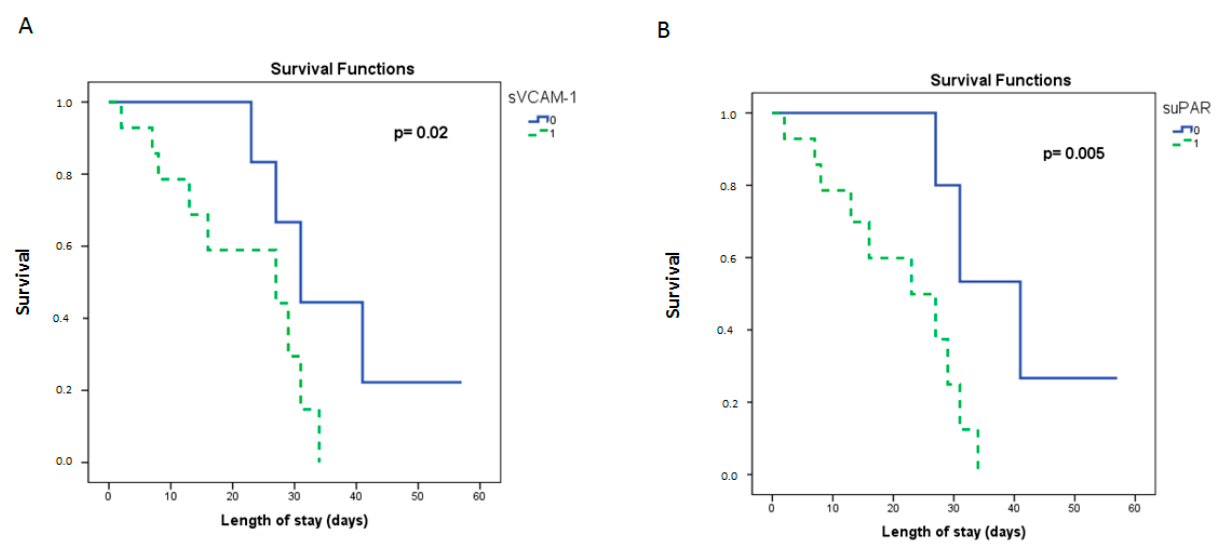
Figure 6. Biomarker levels on admission and intensive care unit (ICU) survival probability. ( A ) sVCAM-1 and ( B ) suPAR were measured on ICU admission (within 24 h). The Kaplan–Meier method was used for ICU survival probability estimation and the log-rank test for two-group comparison. The dexamethasone-treated (first dose—6 mg) group cohort was di- chotomized above and below the respective median value of each biomarker. Dashed lines: ≥ median value (high group, 1); solid lines: < median value (low group, 0). The respective median time to mortality for the two aforementioned groups were as follows: ( A ) sVCAM-1, 37 days (95% CI: 26–48) for the low group, and 22 days (95% CI: 15–28) for the high group (Log-rank test, p = 0.02), and ( B ) suPAR, 40 days (95% CI: 29–51) for the low group, and 21 days (95% CI: 15–27) for the high group (Log-rank test, p = 0.005). suPAR = soluble urokinase-type plasminogen activator receptor; sVCAM-1 = soluble vascular cell adhesion